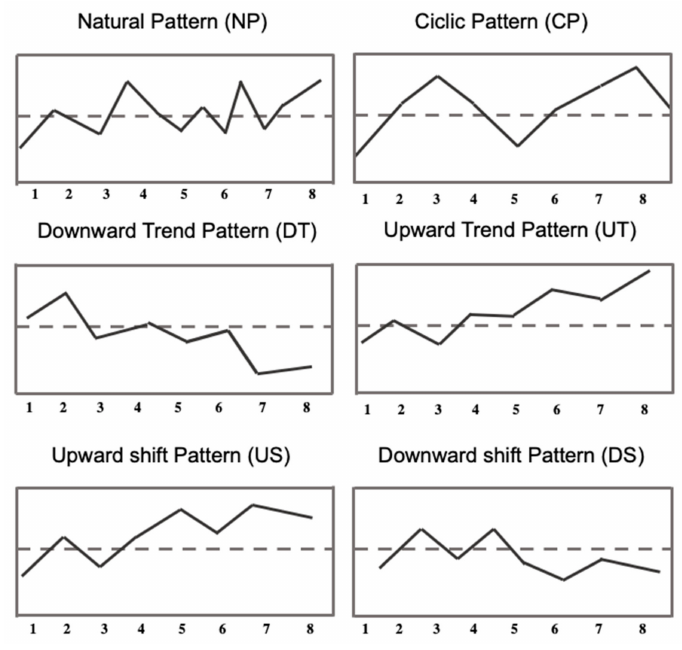
Figure 1. Examples of basic patterns in control charts